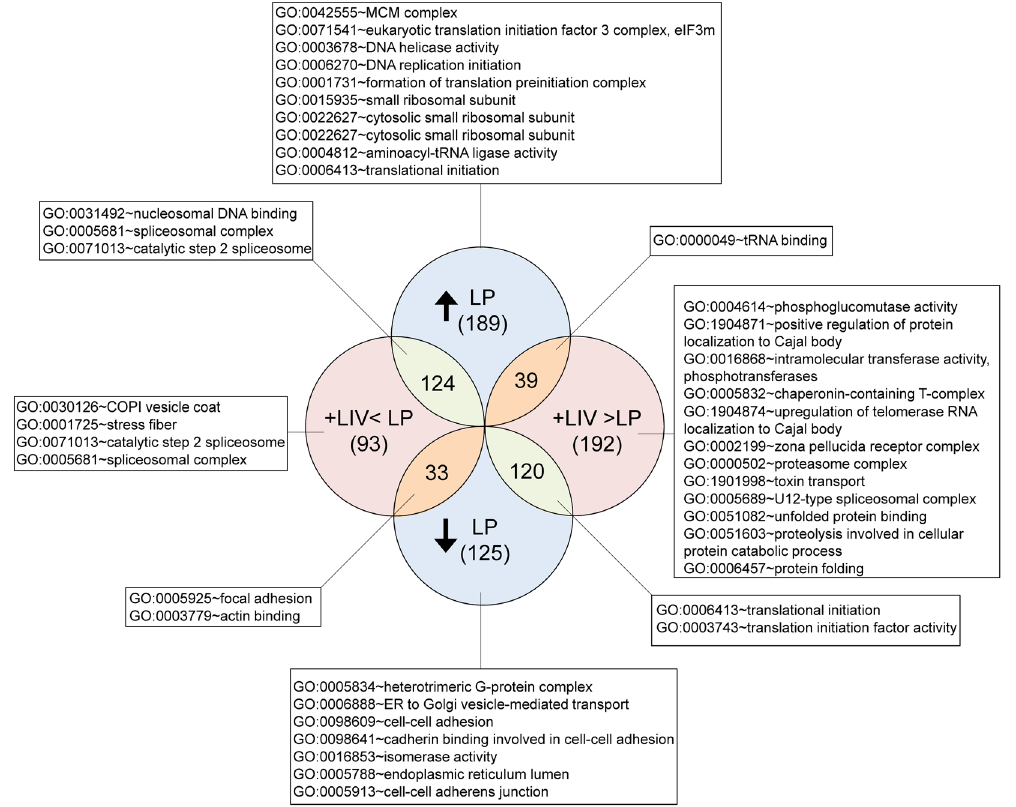
Figure 6. Changes in protein profiles during in vitro expansion and long-term LIV application. When compared to P6, total of 915 unique proteins were identified to be changed ± 25% or more in LP and LP + LIV groups. Functional Annotation Clustering analysis was done via DAVID v6.8 (david.ncifcrf.gov) to identify GO TERMS associated with P6, LP and LP + LIV groups. Only terms with Benjamini score < 0.05 and enrichment score of > 10 were reported. n =